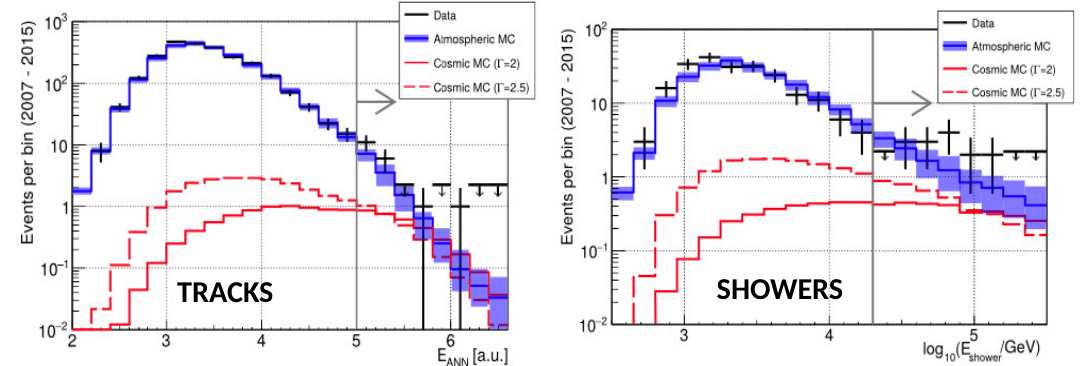
Figure 3. Track (left) and shower (right) energy estimator distributions for the latest ANTARES di ff use fl ux analysis [15]. Arrows mark the optimized energy estimator threshold for the analysis and estimations of the cosmic contribution for two spectral indexes, Γ = 2 and Γ = 2 . 5, are shown.